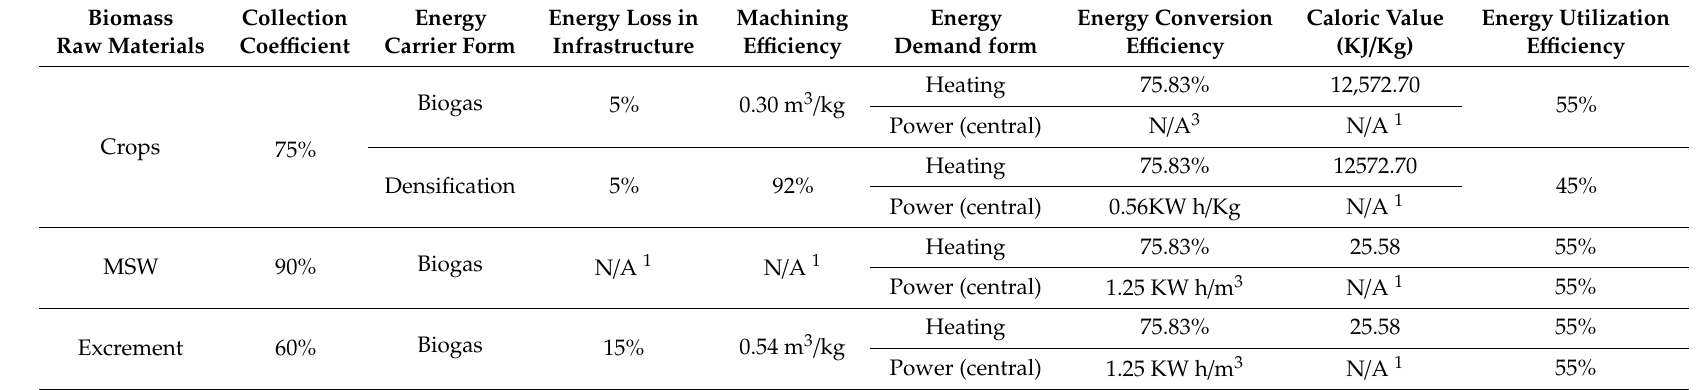
Table 13. Energy conversion parameter